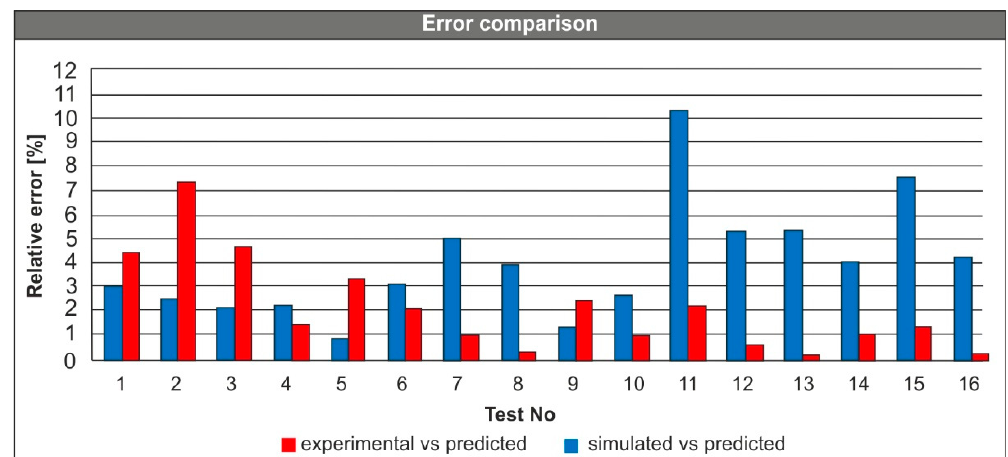
Figure 4. Relative error comparison between the simulated, predicted, and experimental results.